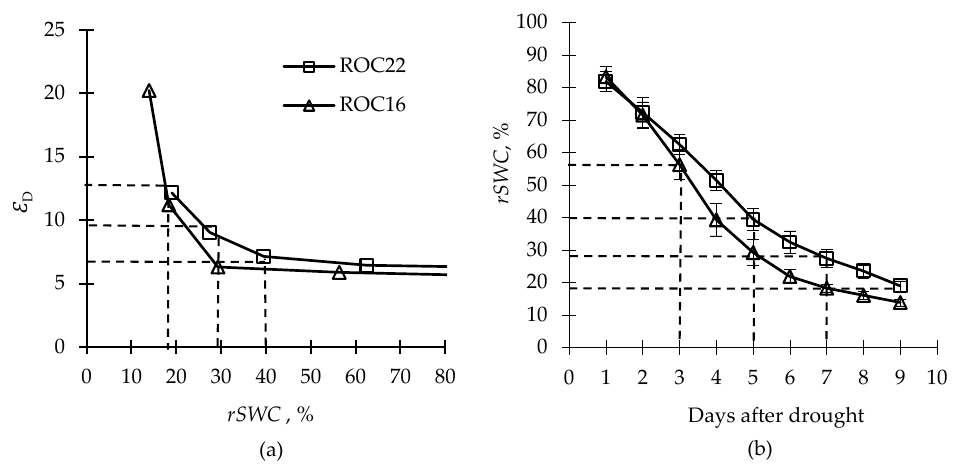
Figure 2. Response ofthe drought-stress index ( E D ) to the relative soil water content ( rSWC ), ( a ) and rSWC after drought treatment of the two sugarcane cultivars ( b ).